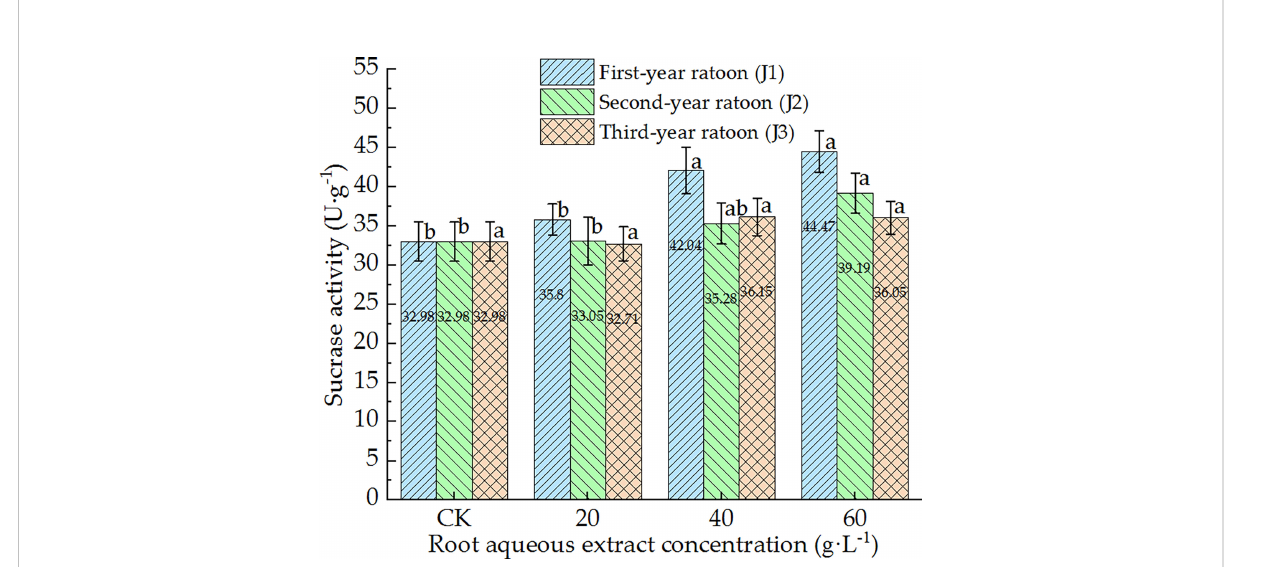
FIGURE 9 Response of SC activity in the culture medium of sugarcane seedlings to different root aqueous extracts. Different lowercase letters represent signi fi cant differences at the 5% level between different concentrations of root aqueous extract with the same ratoon